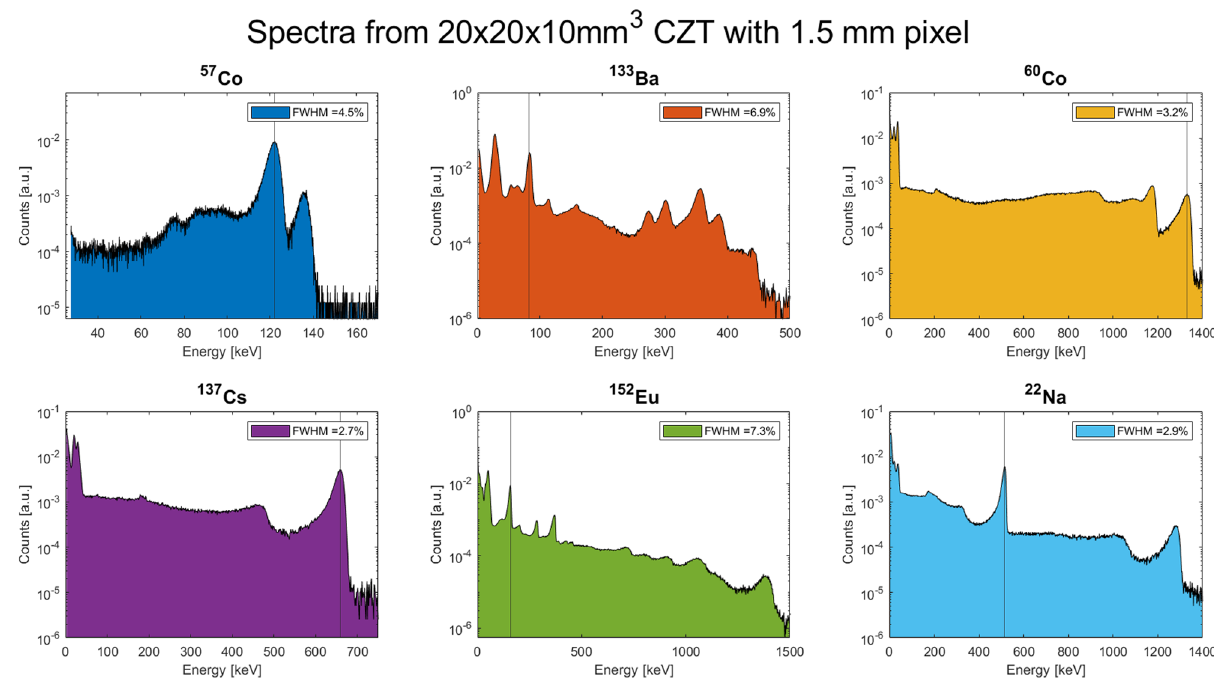
Figure 14. V40 1250A detector response to several nuclear sources. The legend in the subplots reports the FWHM of the photopeak indicated by the vertical line. Measurements were carried out at 20